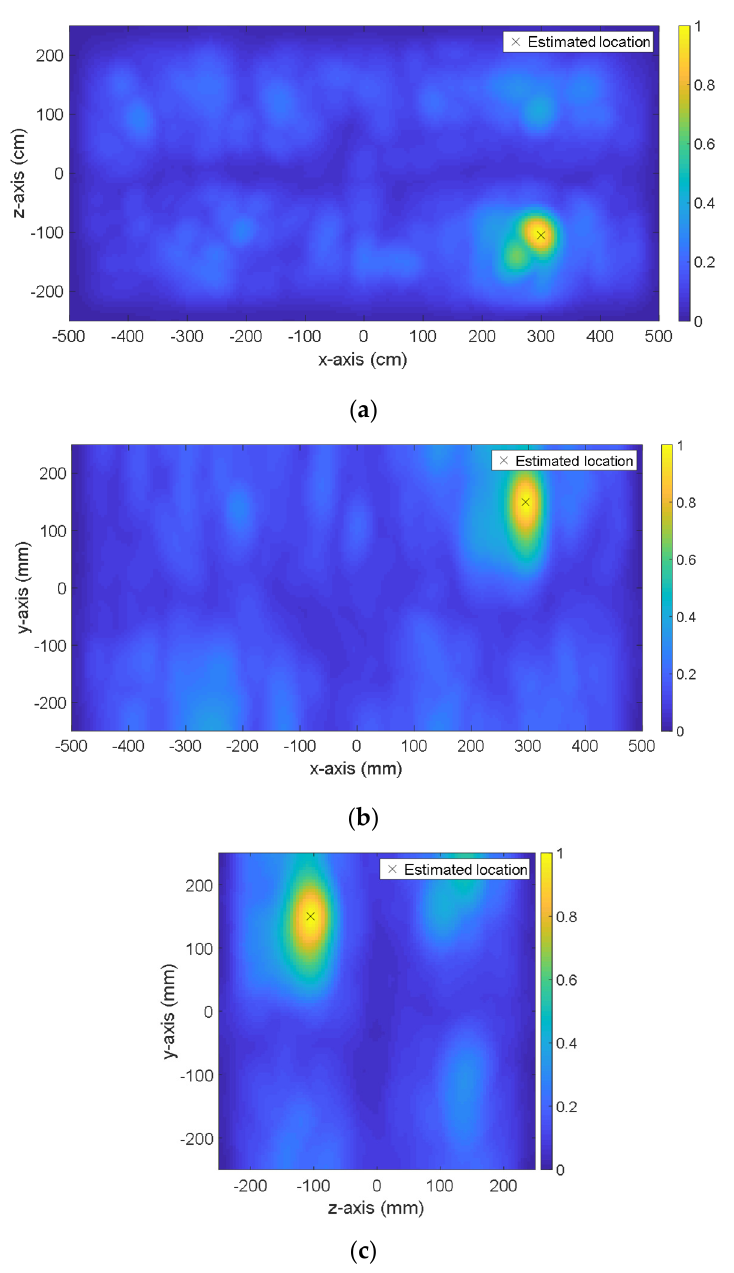
Figure 13. The distribution of normalized maximum electric field power over the complete simulation time interval in the computational domain for ( a ) cut-plane y = 0.16 m, ( b ) cut-plane z = − 0.10 m, and ( c ) cut-plane x = 0.3 m. The black crosses (×) show the estimated location for the PD source. The localization error of the classical EMTR method is 15.1 mm.